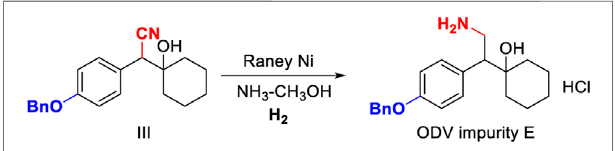
FIGURE 6 | Synthesis and structure con fi rmation of O -desvenlafaxine impurity E.